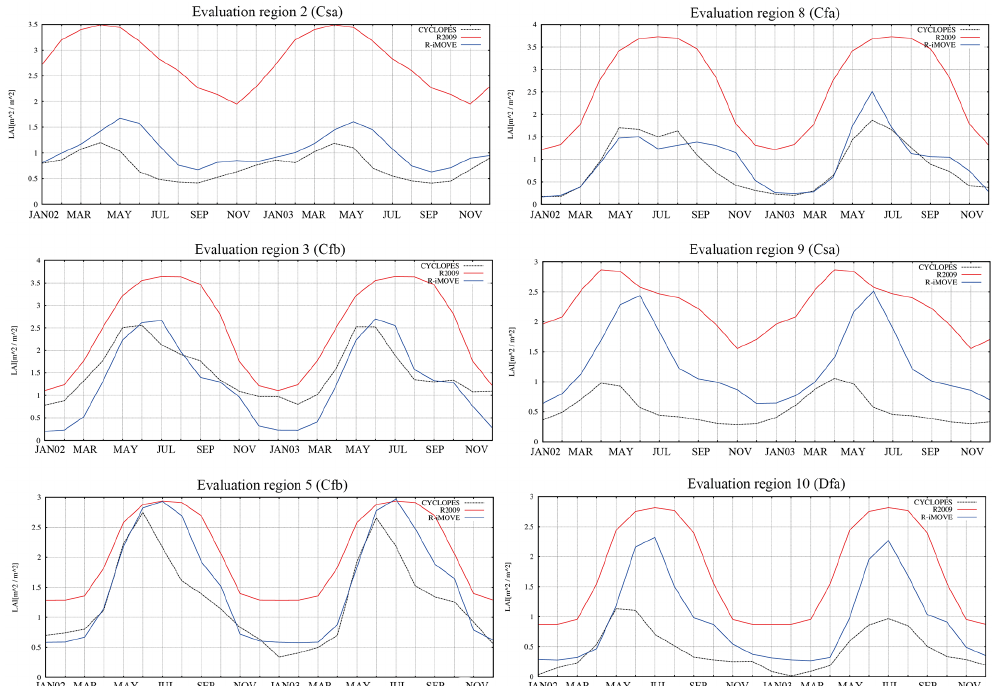
Figure 10. Annual courses of LAI in 2002 and 2003 of REMO-iMOVE, REMO2009 and CYCLOPES (compare Fig.